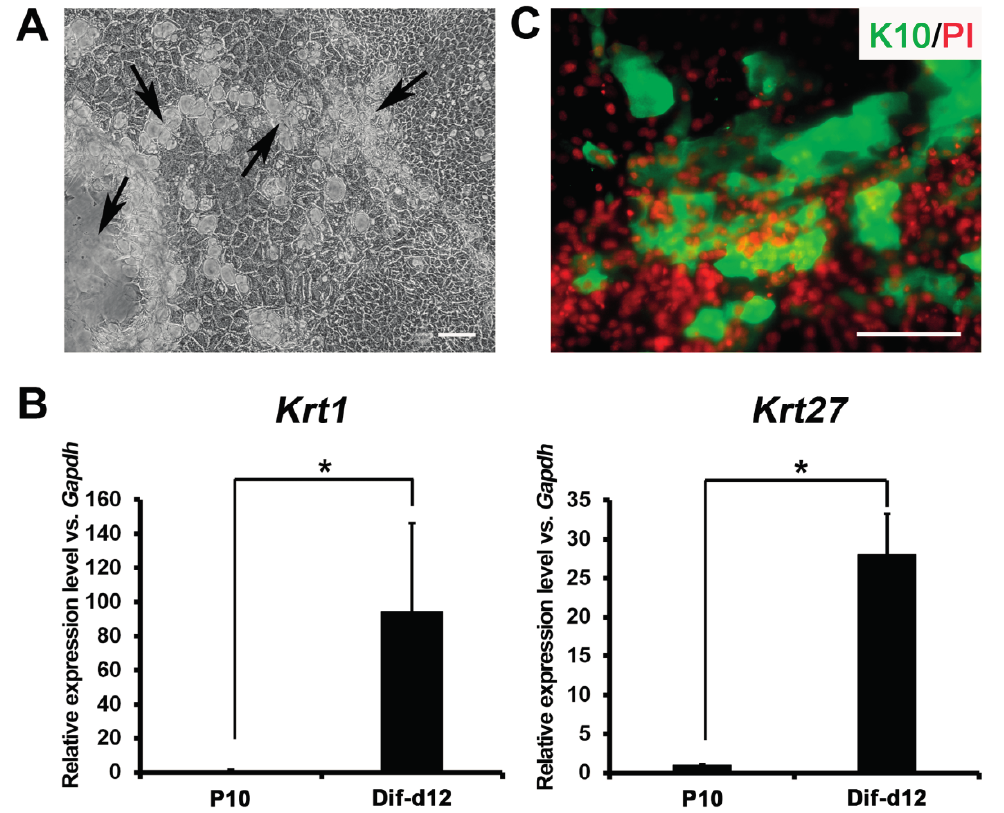
Figure 4. ( A ) Morphology of the differentiated keratinocyte colony after 12 days of confluent culture. The arrows show the multilayer structures formed in the colony; ( B ) qRT-PCR results showing the expression of Krt1 and Krt27 in P10 undifferentiated bulge-derived keratinocytes and differentiated keratinocytafter 12 days of confluent culture (Differentiated after day 12 (Dif-d12)); ( C ) Immunostaining of K10 in the differentiated keratinocyte colony after 12 days of confluent culture. Scale bar, 100 μ m. * p < 0.05. 2.5. Skin Reconstitution with Ovine Bulge-Derived Keratinocytes and Neonatal Dermal